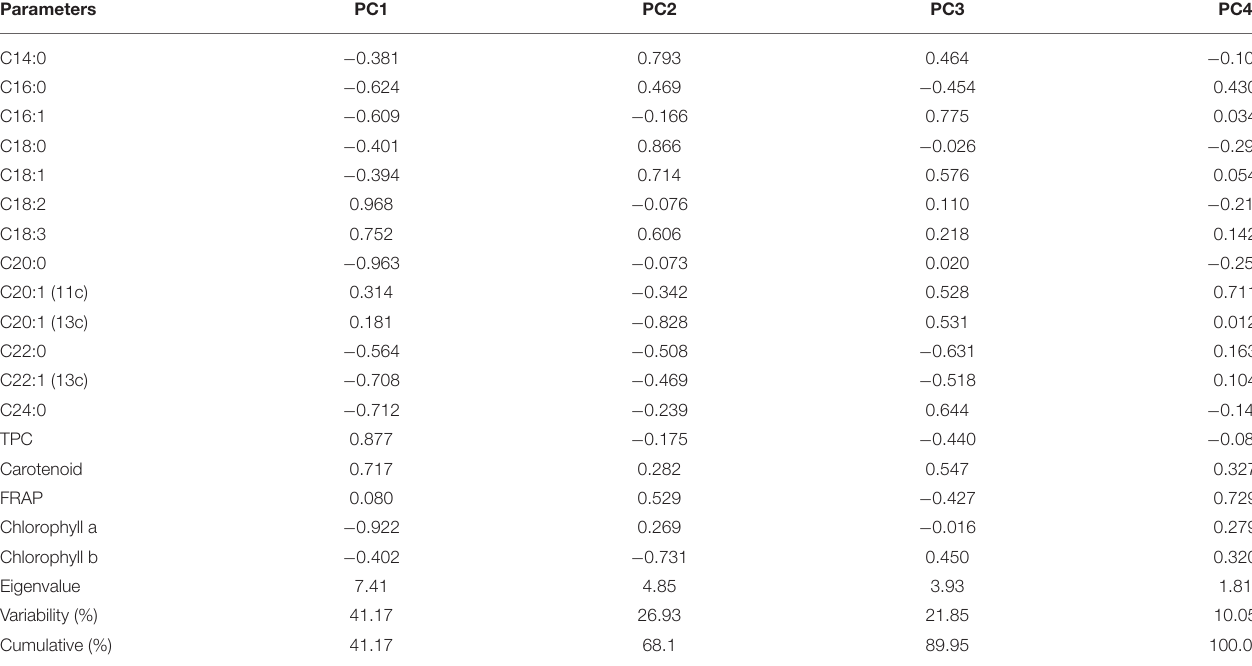
TABLE 5 | Eigen analysis of the loadings of the significant principal components (PCs) for the niger seed varieties. Parameters